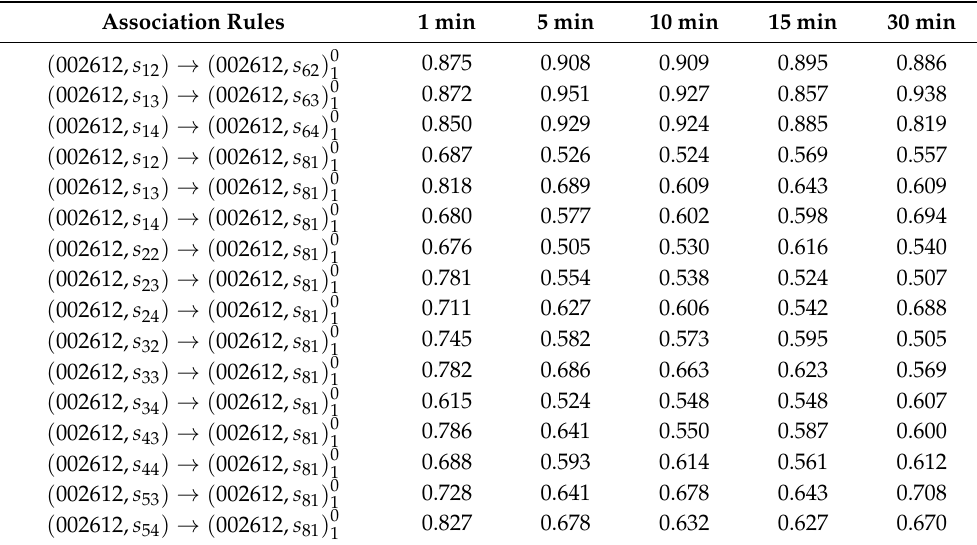
Table 4. Comparison of confidence for 1-sized fuzzy temporal adjacency association rules.